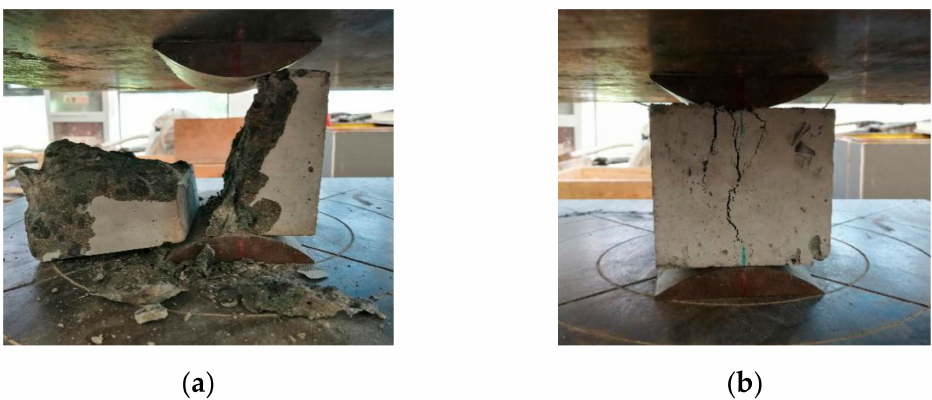
Figure 4. Comparison of splitting failure modes of specimens: ( a ) Reference group; ( b ) hybrid fiber group.